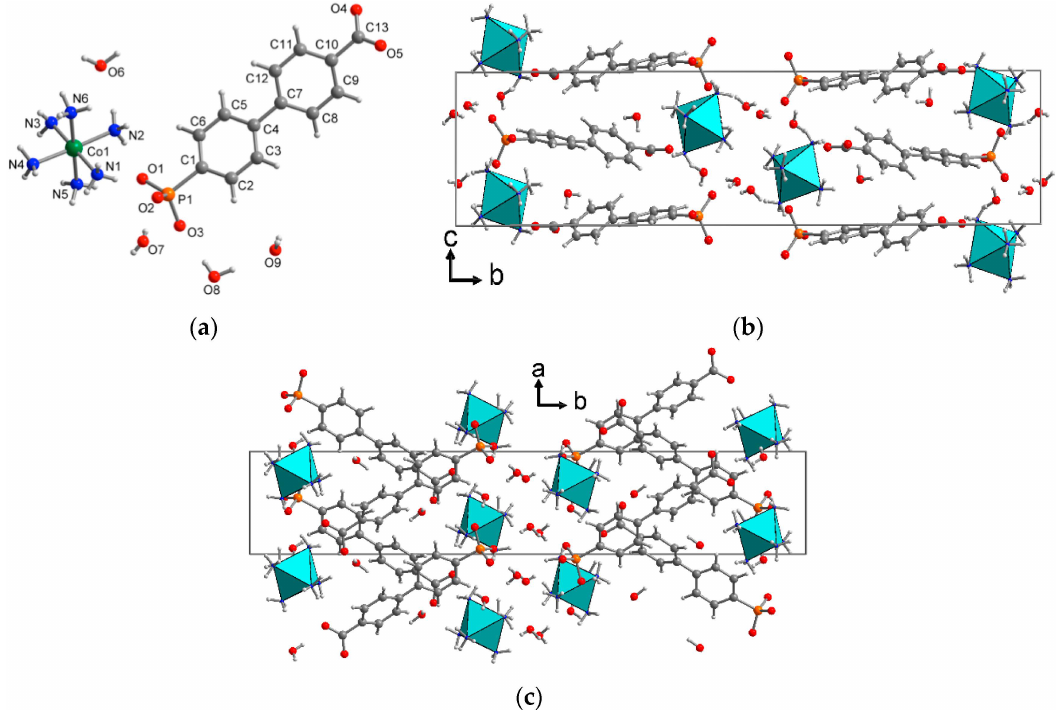
Figure 3. ( a ) Asymmetric unit of 2 ; and ( b , c ) projections of the unit-cell packing on different planes. The [Co(NH 3 ) 6 ] 3+ cations are illustrated as octahedra; hydrogen bonds are not shown in ( a – c ) for clarity. Selected bond distances and angles are given in Table